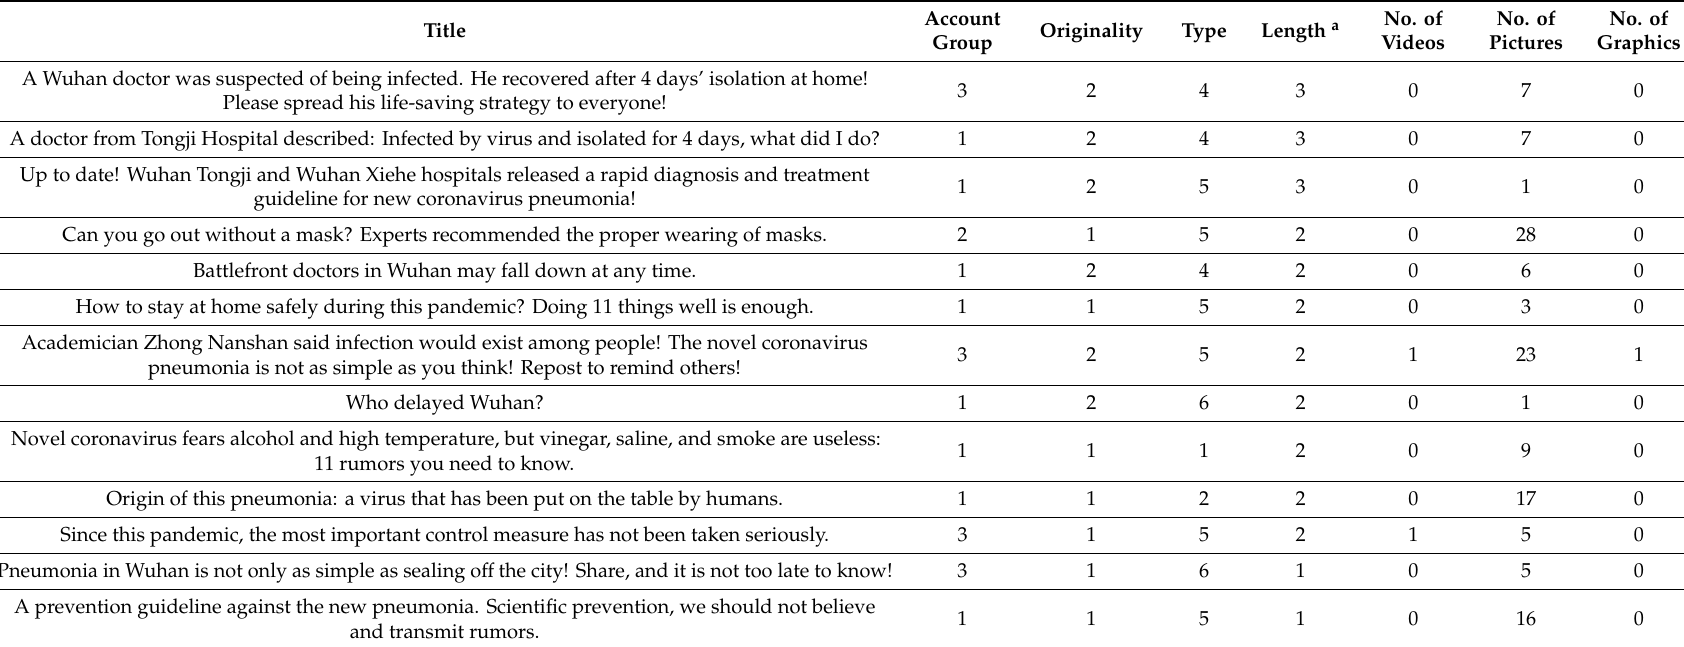
Table 5. The coding results and